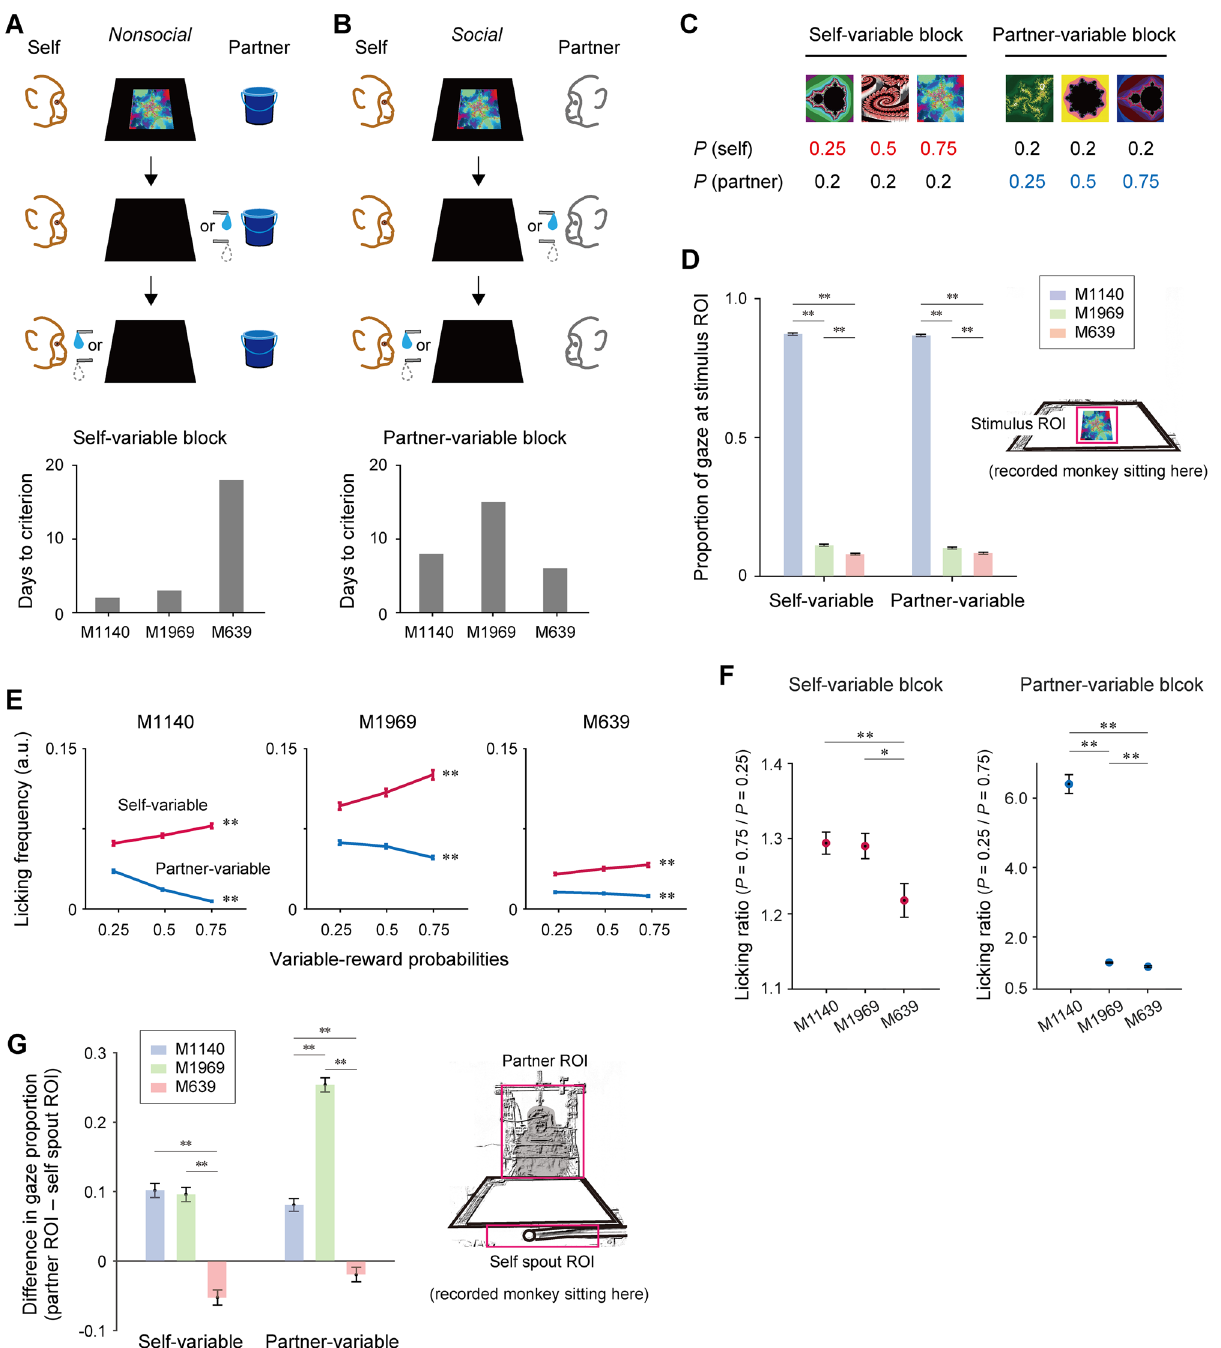
Figure 4. Pavlovian conditioning procedures for M639. ( A ) Top , sequence of events in non-social Pavlovian conditioning. Bottom , learning days required for the emergence of licking differentiation in the self-variable block. ( B ) Top , sequence of events in social Pavlovian conditioning. Bottom , learning days required for the emergence of licking differentiation in the partner-variable block. ( C ) Reward probability assigned to each conditioned stimulus. P (self), probability of self-reward. P (partner), probability of partner reward. ( D ) Proportions of gaze at the stimulus ROI during the stimulus period. Mean ± SEM; ** P < 0.01, two-tailed Welch’s t -test. ( E ) Subjective value modulation expressed in anticipatory licking. Mean ± SEM; ** P < 0.01, Spearman’s correlation test. Variable-reward probabilities denote reward probabilities that were variable in each block (corresponding to colored numerical values in ( C )). ( F ) Licking ratio as a measure of the magnitude of subjective value modulation. Mean ± SEM; ** P < 0.01, * P < 0.05, two-tailed Welch’s t -test. ( G ) Proportions of gaze at the partner ROI and self-spout ROI when the partner was rewarded (100–500 ms after reward was presented to the partner). Same conventions as in ( D